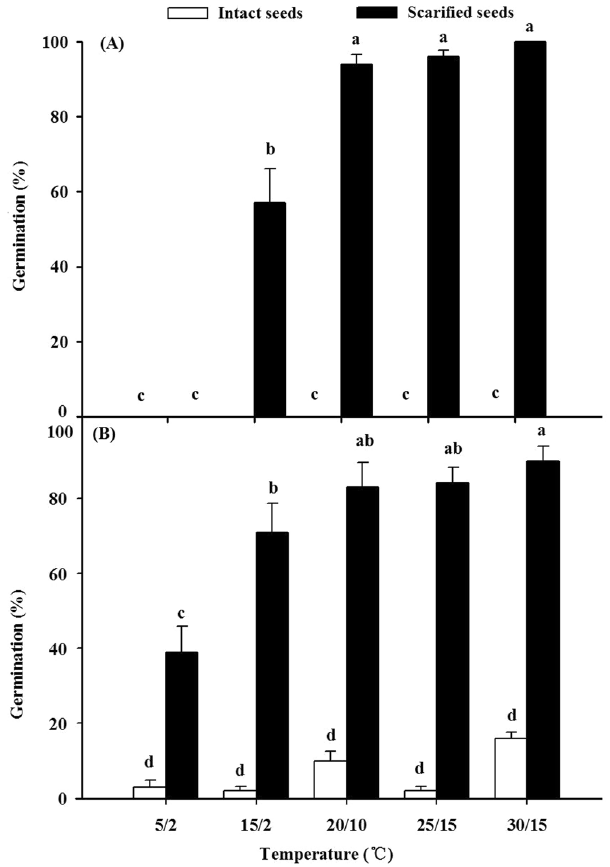
Figure 2. Germination (mean% + se) of fresh intact ( ▫ ) and scarified ( ▪ ) seeds of Aslragalus lehmannianus in light ( A ) and darkness ( B ). Bars in ( A ) and in ( B ) with different lowercase letters are significantly different ( P <